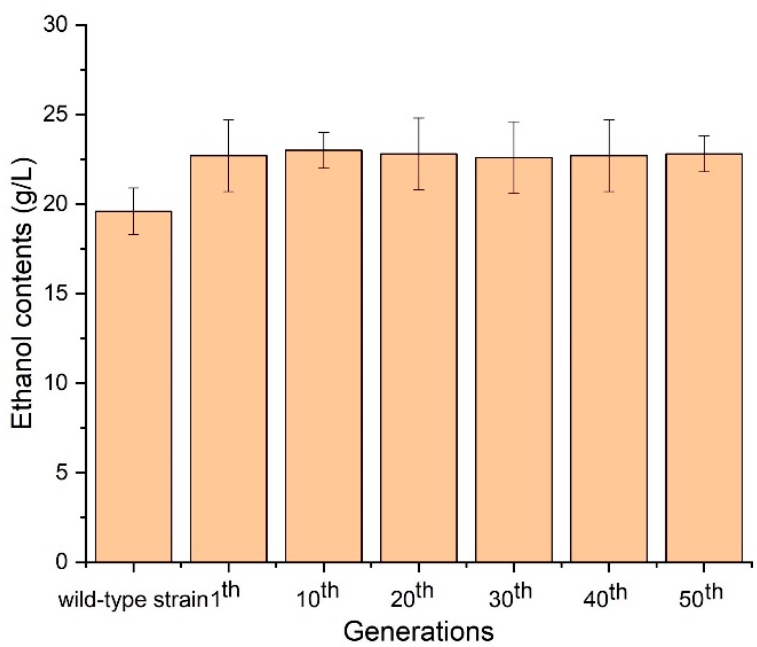
Figure 11. Ethanol contents of SCGFA engineering strains from multiple generations.